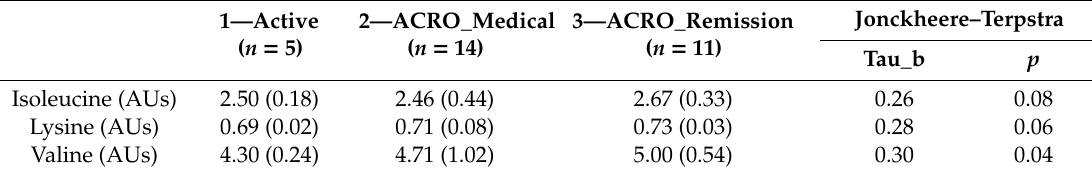
Table 4. Amino-acid concentration according to disease